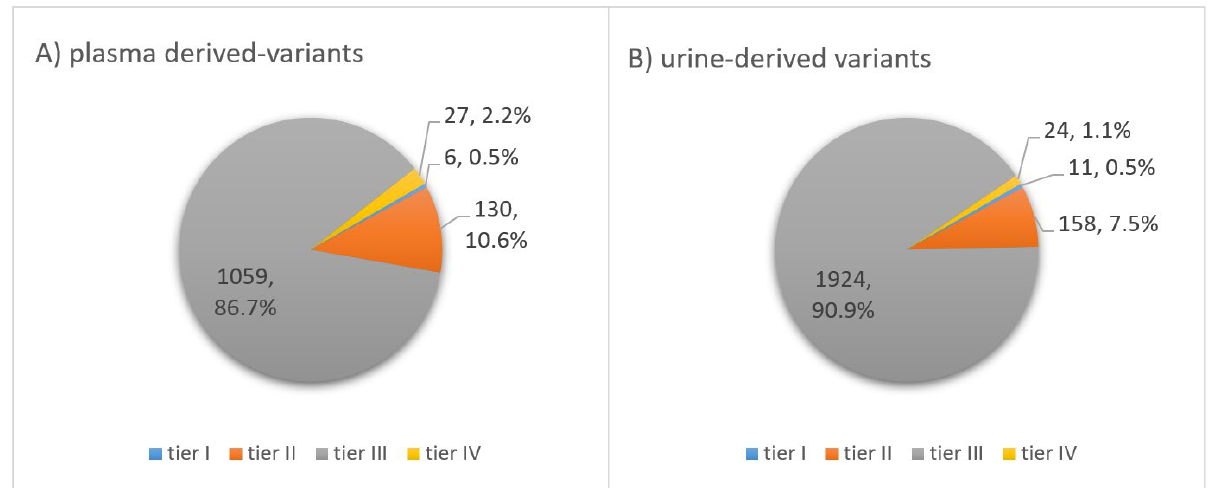
Figure 5. Clinical Significance. Classification of somatic variants found in ctDNA of ( A ) plasma and ( B ) matching urine samples according to their clinical significance. Using QCI Interpret Translational (QIAGEN), variants were classified into four tiers: Variants in tier I are of strong clinical significance (level A and B evidence), variants in tier II are of potential clinical significance (level C and D evidence), variants in tier III are of unknown clinical significance and variants in tier IV are characterized to be benign or likely